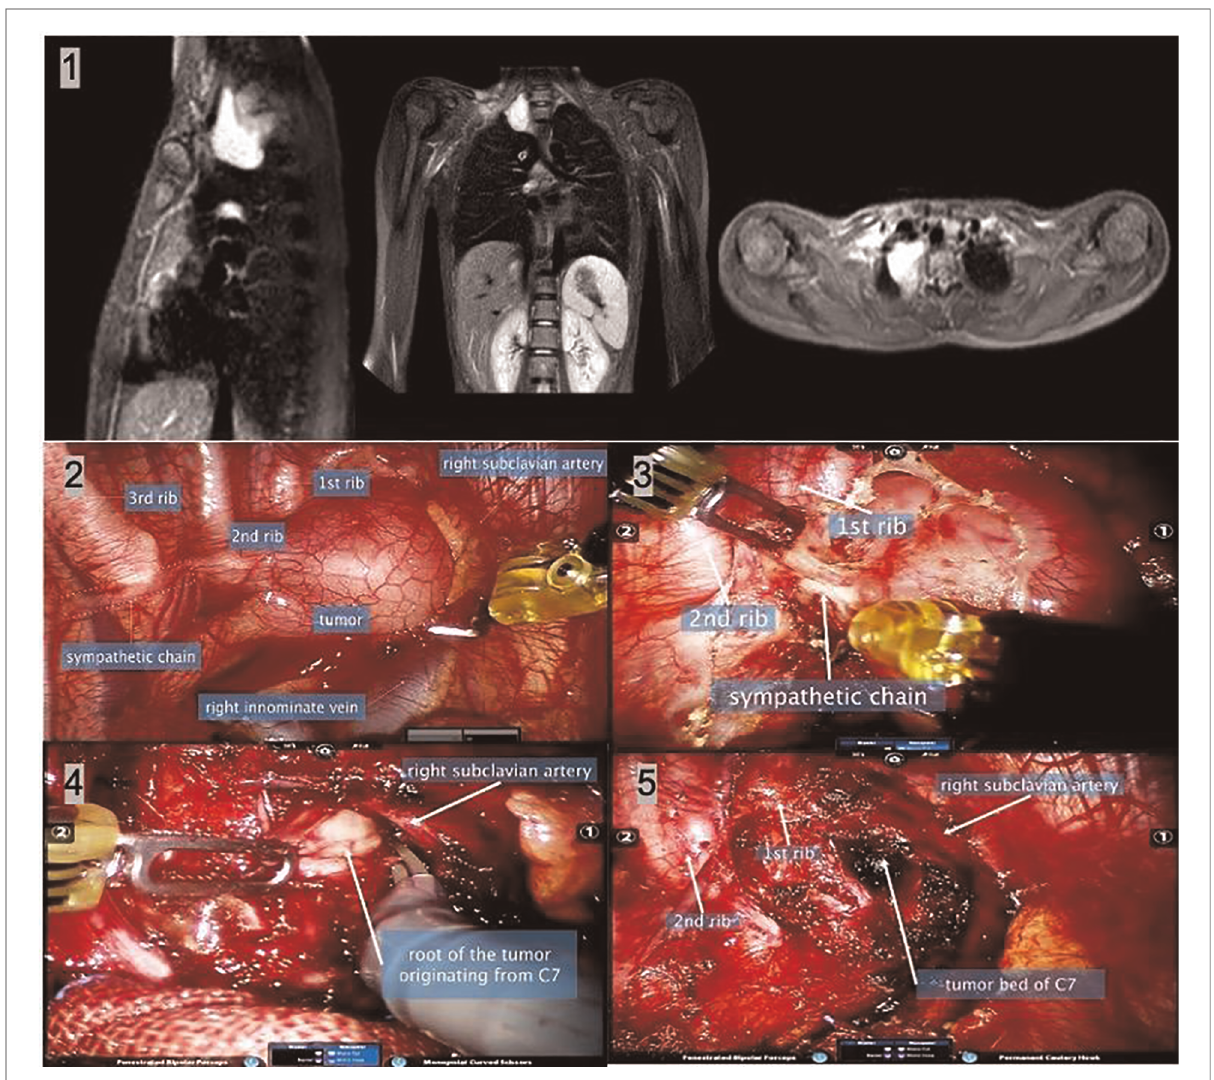
FIGURE 3 A 13-year-old girl with cervical-mediastinal ganglioneuroma. (1) The thoracic MR shows a lesion located at the right outlet of the chest with a wide base. (2) Intraoperative image shows the lesion and adjacent structures. (3) After separating the mediastinal pleura, the sympathetic nerve chain was found to enter the tumor, which was disconnected, resulting in postoperative Horner ’ s syndrome. (4) Intraoperative frozen diagnosis was a benign tumor. To fully reveal the root of the tumor, most of the tumors were removed fi rst, and the tumor was found to originate from the C7 nerve root. The root of the tumor was sharply separated with monopolar curved scissors. (5) The image shows the surgical fi eld after complete tumor resection. Postoperatively, the patient developed right upper limb weakness, and symptoms were relieved 2 months postoperatively. MR, magnetic